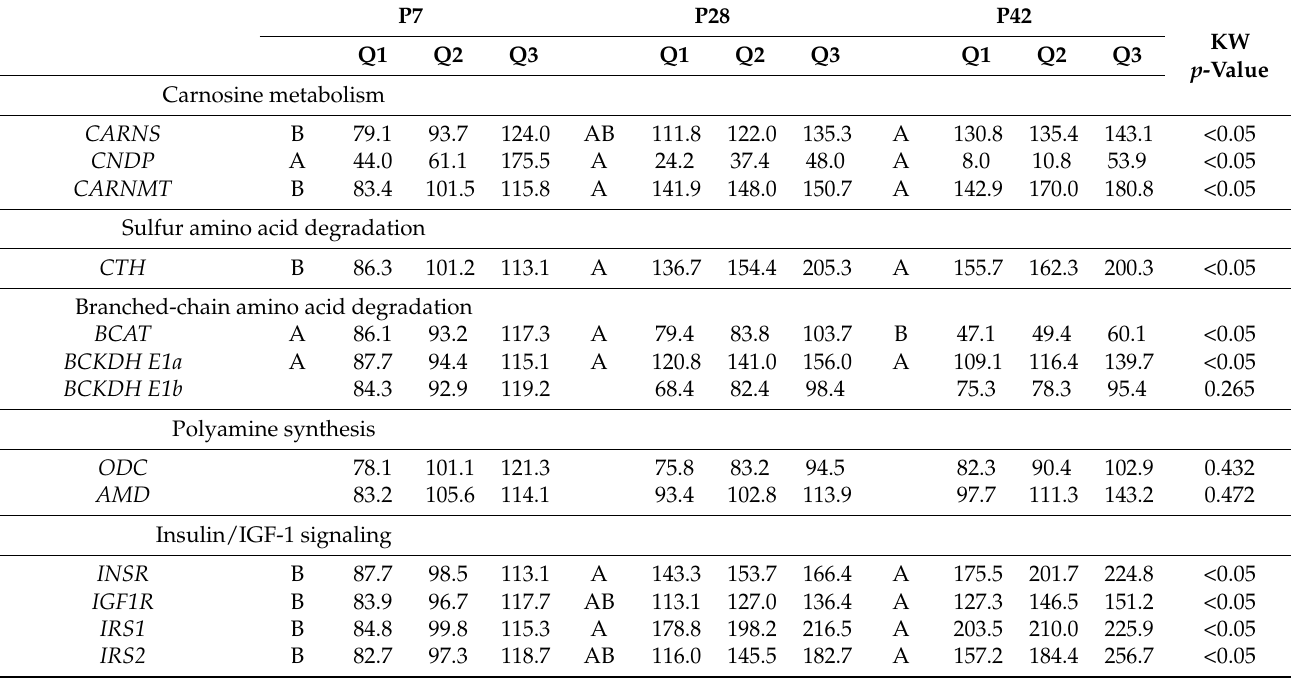
Table 7. Relative mRNA expressions of the breast muscle during post-hatch developmental period in chickens.